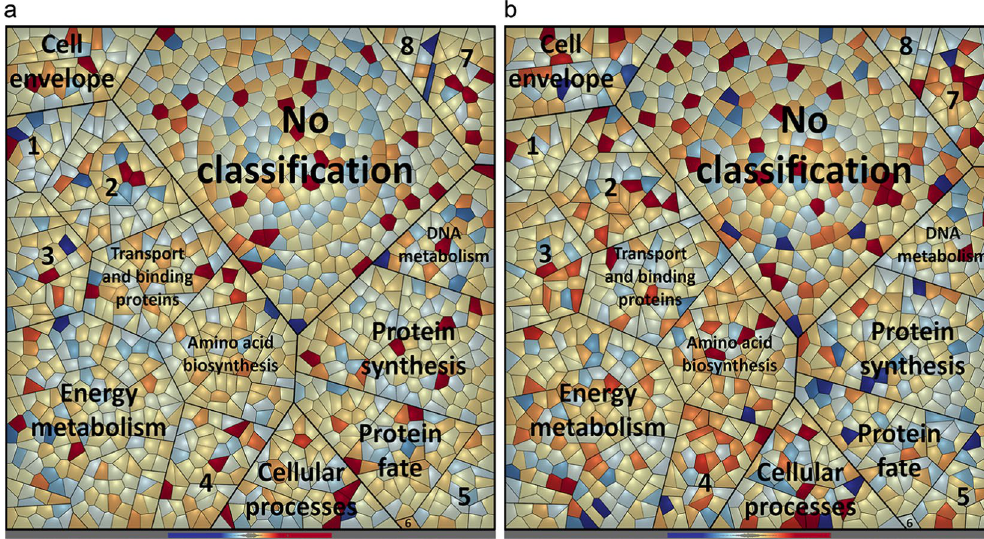
Figure 3. Voronoi treemaps visualizing changes in the proteome composition of S. plymuthica PRI-2C exposed to fungal VOCs. Quantitative expression values of S. plymuthica PRI-2C proteins at t1 of exposure ( a ) and at t2 ( b ). Functional classification of proteins was carried out by Prophane 2.0 and is based on TIGRFAMS. Red color indicates higher expression of the respective protein and blue color indicates lower expression as compared to the control. Each cell represents a single protein. Functional classes are separated by thicker black lines. Numbers indicate the following classes: 1 - Fatty acid and phospholipid metabolism, 2 - Biosynthesis of cofactors, prosthetic groups, and carriers, 3 - Purines, pyrimidines, nucleosides, and nucleotides, 4 - Central intermediary metabolism, 5 - Transcription, 6 - Mobile and extrachromosomal element functions, 7 - Regulatory functions, 8 - Signal transduction.